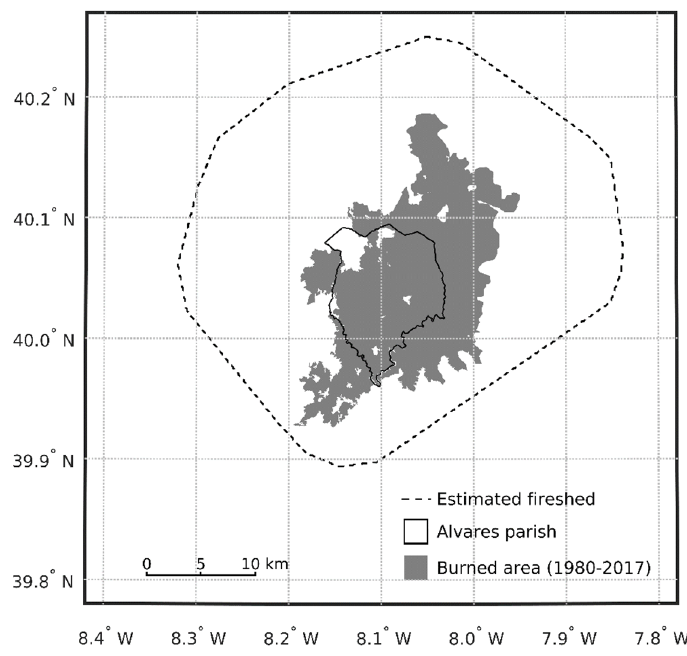
Figure A3. Estimated fireshed (historical calibration period) and the observed wildfire footprint between 1980 and 2017.